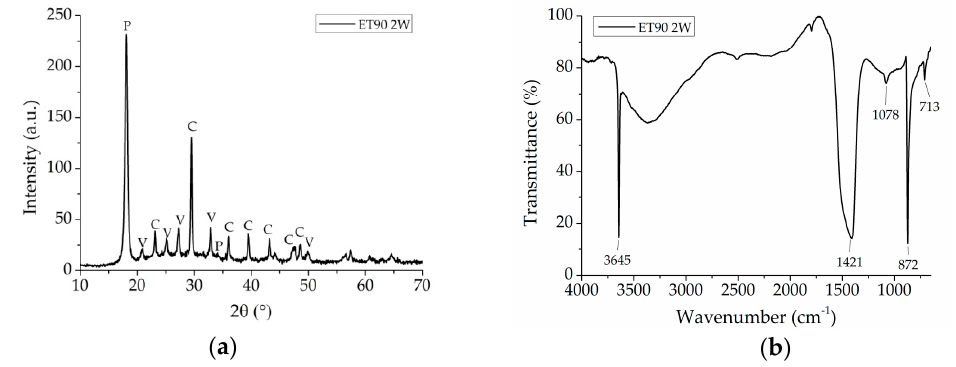
Figure 4. Ca(OEt) 2 at 90% RH after two weeks (ET90 2W): ( a ) XRD pattern; ( b ) μ FT-IR spectrum. XRD peak assignments: P, portlandite; C, calcite; V, vaterite.